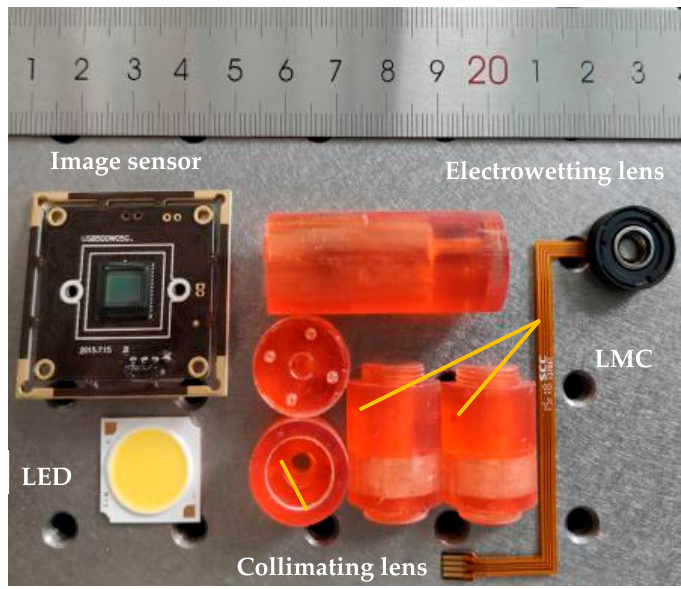
Figure 3. Components of the proposed system.